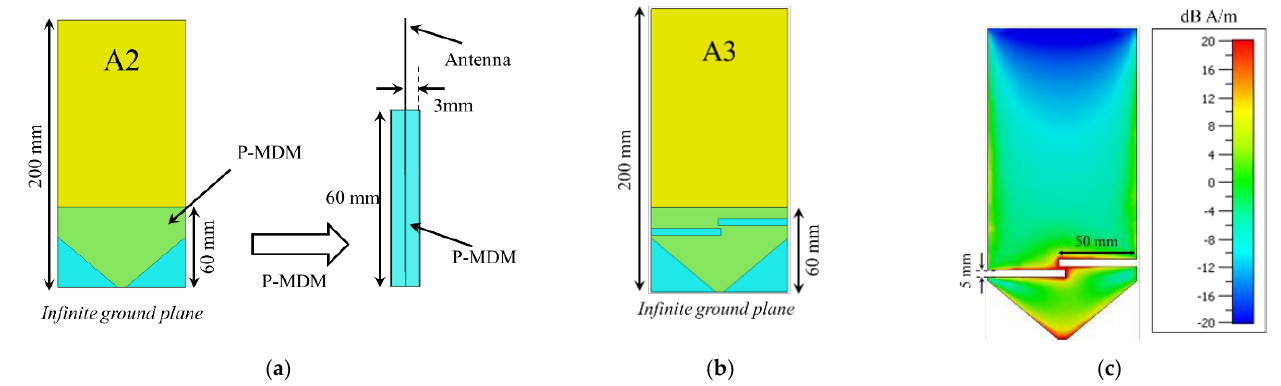
Figure 3. Monopole antenna miniaturized by the P − MDM: ( a ) without slots (A2) and ( b ) with two slots of 50 mm × 5 mm (A3). ( c ) Density of the surface currents (A/m), which corresponds to the intensity of the magnetic field.